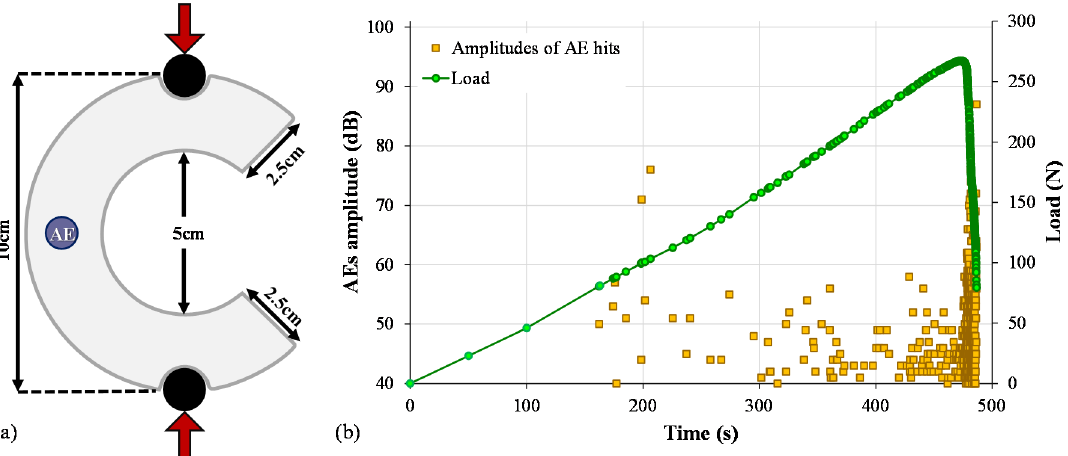
Figure 9. ( a ) The geometrical characteristics of the CSR marble specimen. The red arrows indicate the direction of the imposed force, and the black circles represent the cylinders used to apply the force. ( b ) The temporal evolution of the amplitudes of the acoustic hits in juxtaposition to that of the force.